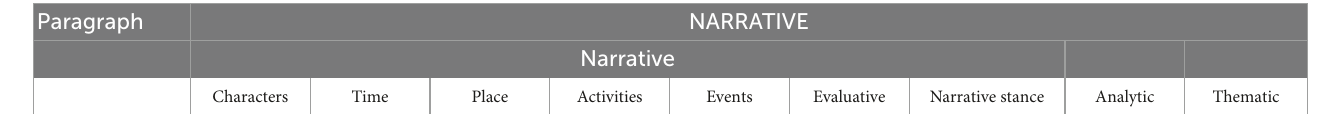
TABLE 2 NARRATIVE analysis scheme.